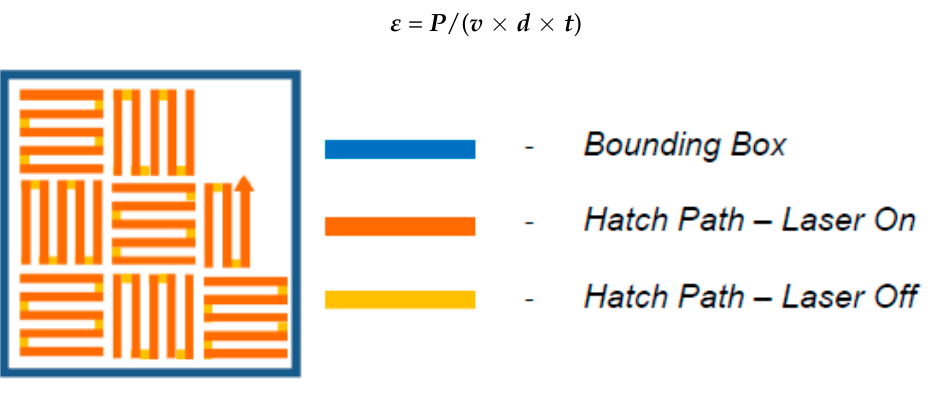
Figure 1. Chessboard printing strategy [45].